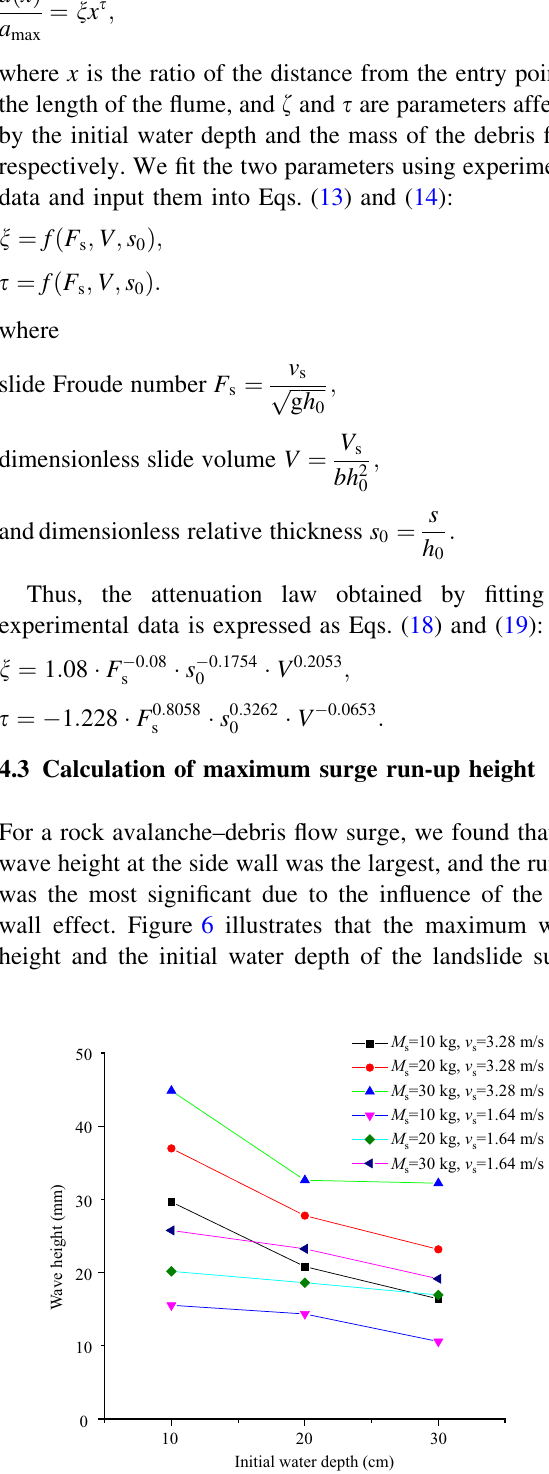
Fig. 7 Comparison of the measured and calculated values using Eq.